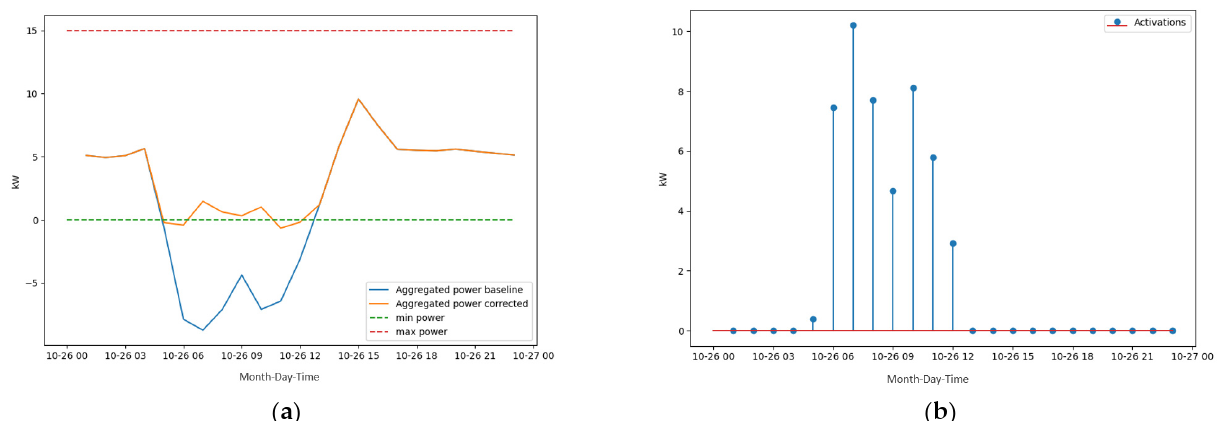
Figure 3. The baseline (forecasted) aggregated power (blue) has injections to the grid during the morning hours and noon. The optimised aggregated power reduces these injections, achieving close to zero consumption during those hours. ( a ) Example of the DA’s operation; ( b ) computed activations by the DA.